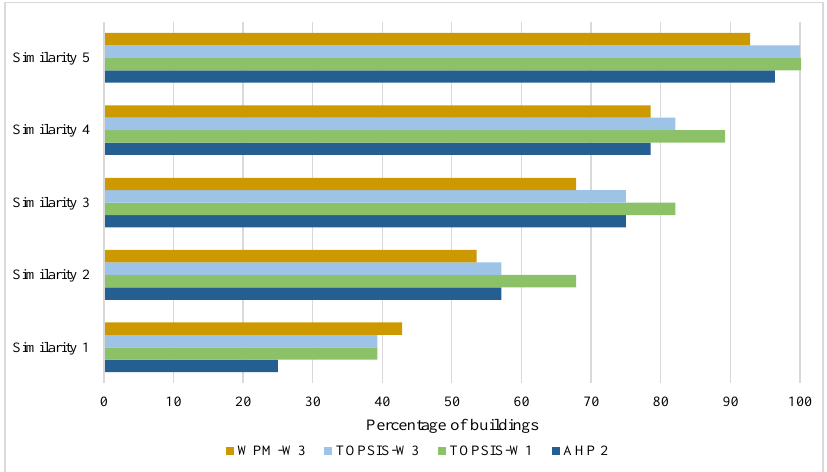
Figure 4. Similarities illustrated by the percentage of buildings for all proposed MCDM methods.